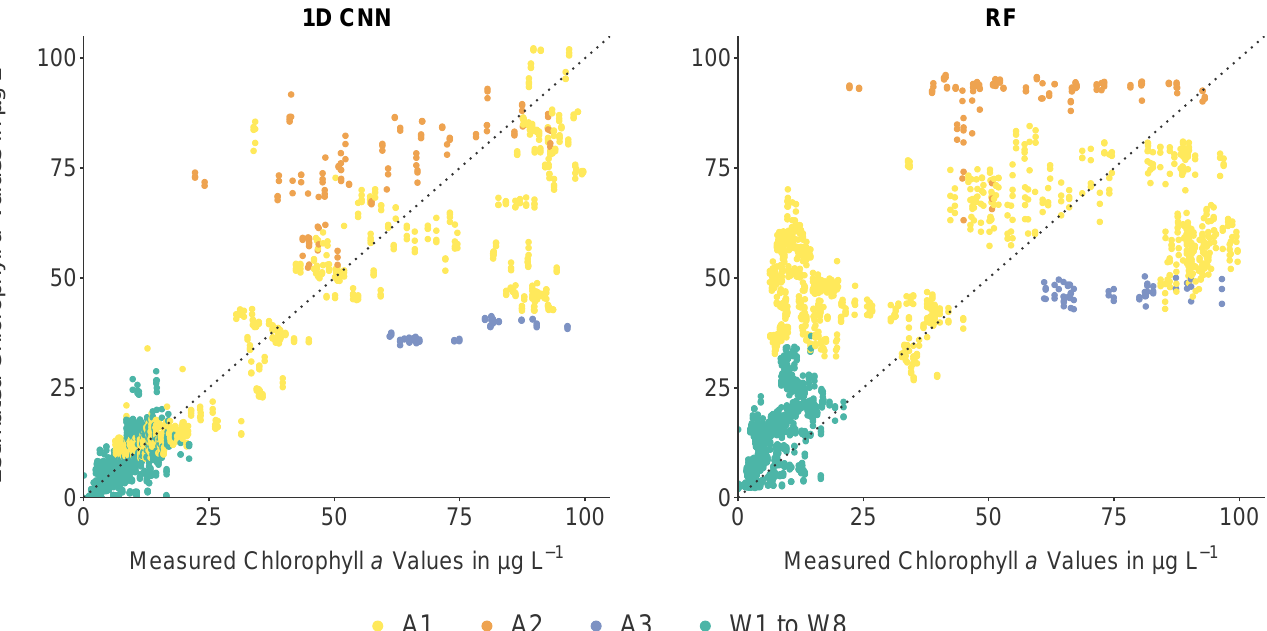
Figure 8. Visualization of the estimation results (y-axes) generated by the 1D CNN and the baseline RF model compared to the measured chlorophyll a values (x-axes) on the SpecWa dataset. The natural water bodies W1 to W8 are colored in green while the artificial water bodies are characterized by three different colors: A1 in yellow, A2 in orange, and A3 in